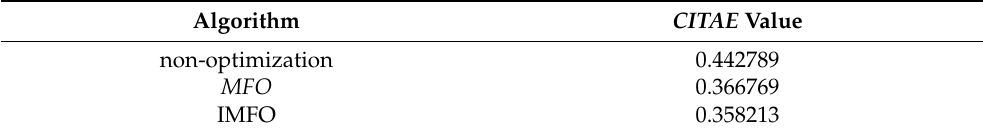
Table 5. Comparison of evaluation indexes before and after